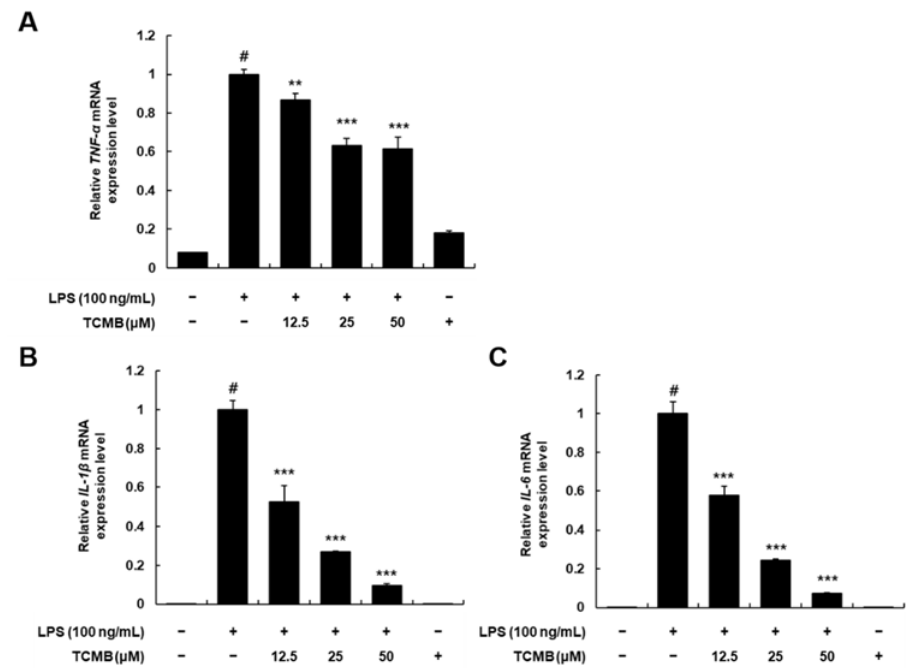
Figure 6. Effects of TCMB ( 11 ) on mRNA expression level of TNF ‐α ( A ), IL ‐ 1 β ( B ), and IL ‐ 6 ( C ) in LPS ‐ stimulated RAW 264.7 macrophages. The cells were pretreated with compounds at concentrations of 12.5, 25, and 50 μ M for 6 h and then were stimulated with LPS (100 ng/mL). Values are expressed as means ± SD. # p < 0.05 vs. non ‐ LPS ‐ induced control group; ** p < 0.01 and *** p < 0.001 as compared to the LPS only ‐ induced group.